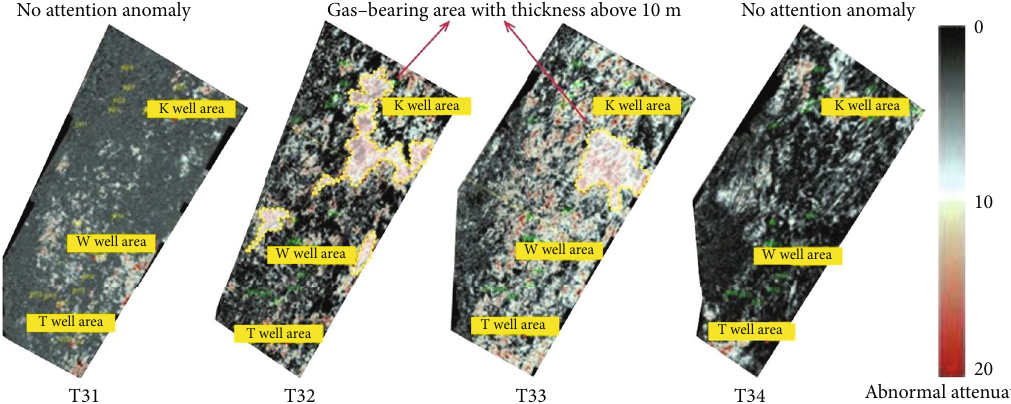
Figure 14: Prediction of gas-bearing traps by seismic wave attenuation method in Pinghu